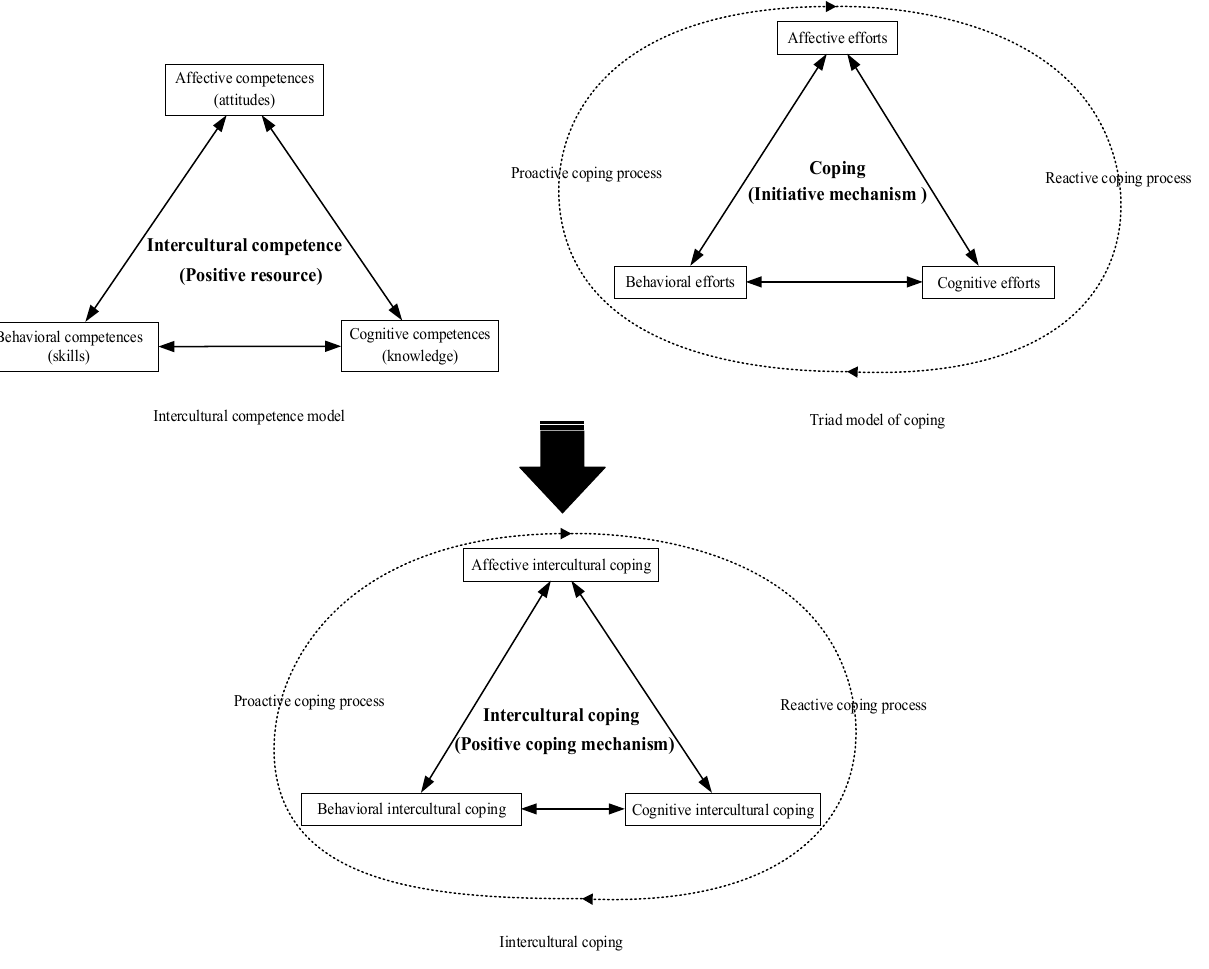
Figure 2. Integration of intercultural competence and coping.